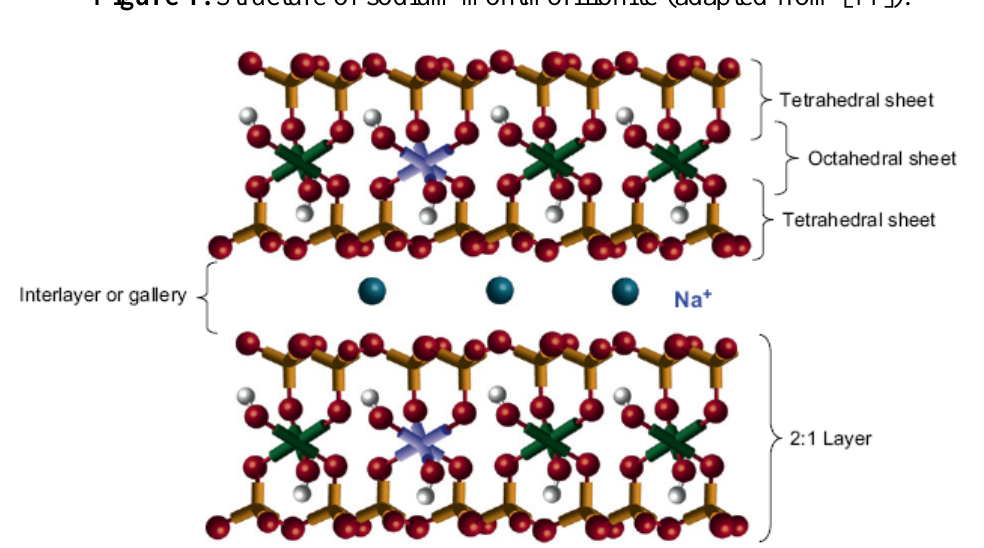
Figure 1. Structure of sodium montmorillonite (adapted from